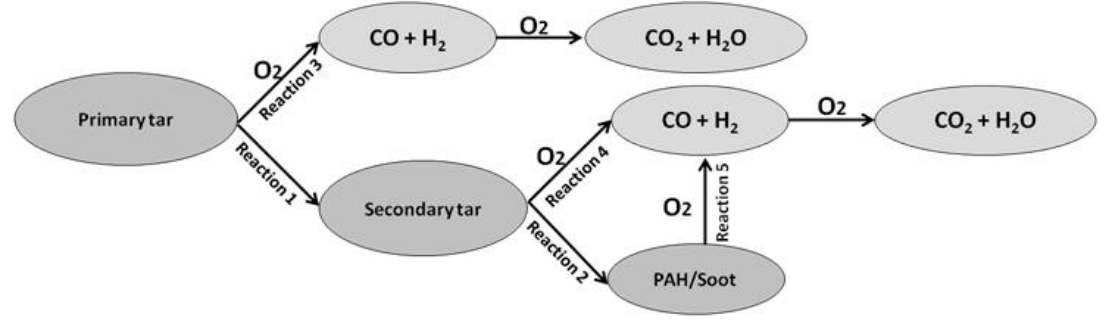
Figure 1. Lumped reaction scheme.